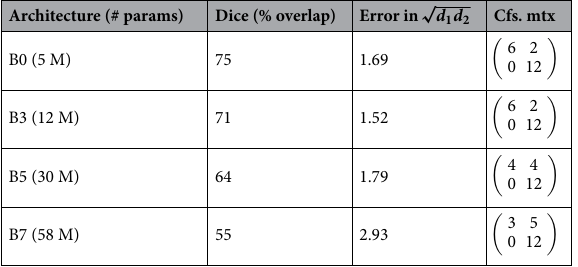
Table 5. The effect of architecture size on slide-level tasks, using the K-means negative sampling, 256 as the tile stride, and only random cropping as augmentation.